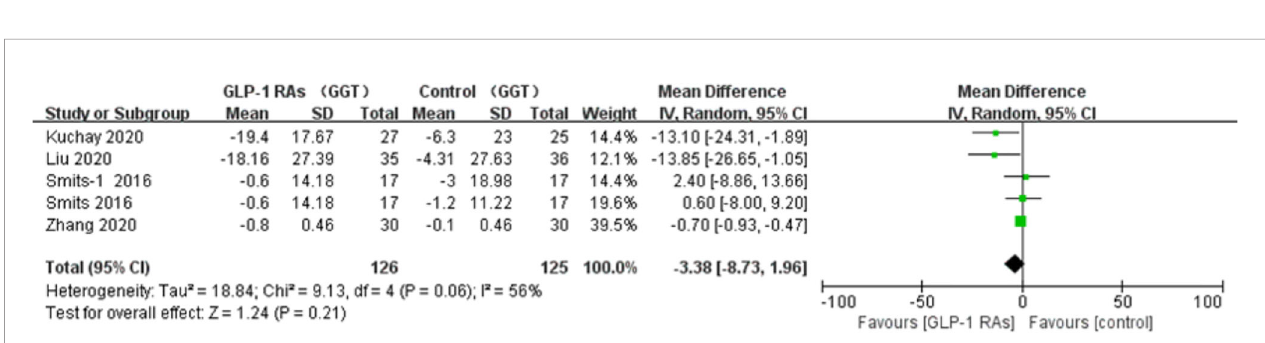
FIGURE 11 | Glucagon-like peptide-I receptor agonists (GLP- 1 RAs); gamma-glutamyl transpcptidase (GGT); SD, standard deviation; CI, con fi dence interval; IV, inverse variance; Smits-l, concluded liraglutide vs placebo.